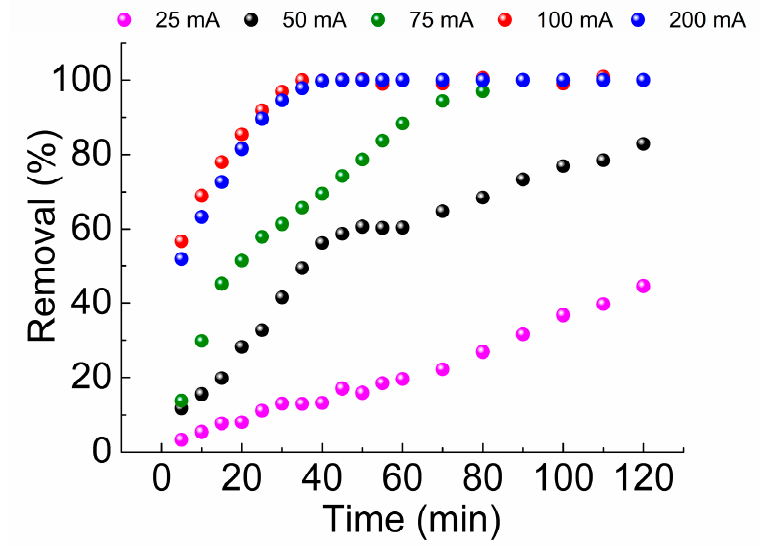
Figure 6. Effect of applied current on 20 mg·L − 1 MB degradation by electrofenton using RVC dip coated as cathode.